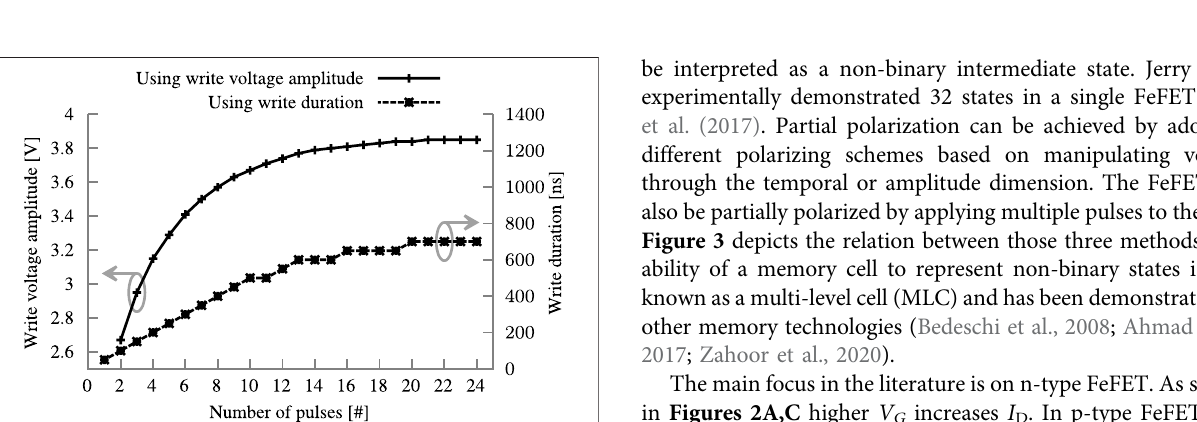
Frontiers in Electronics |